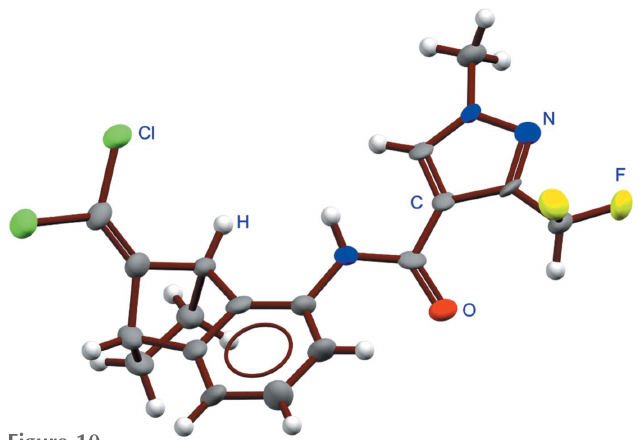
Figure 10 ORTEP -style Mercury rendering of